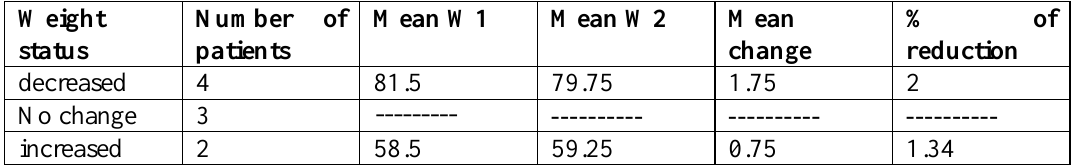
Table 9: shows the weight status in patients with TSH2 decrease after metformin for a normal TSH1. (W 1 =initial weight, W 2= weight after metformin).